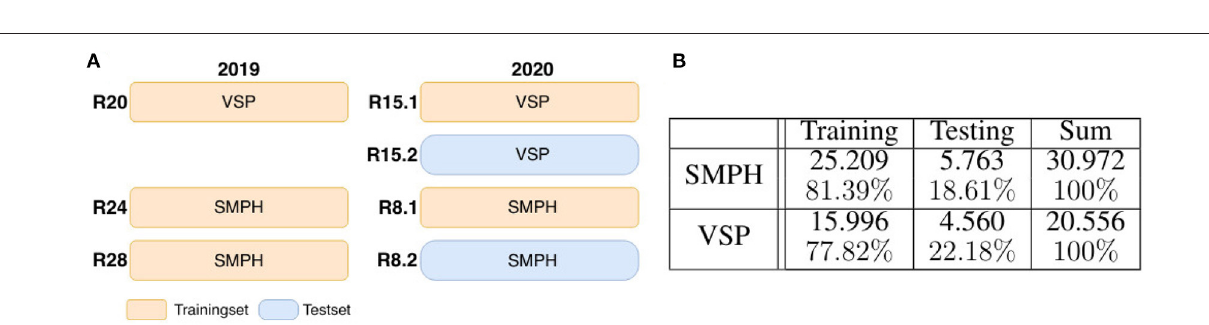
The test data is taken from the dataset collected in 2020 (see Figure 6A